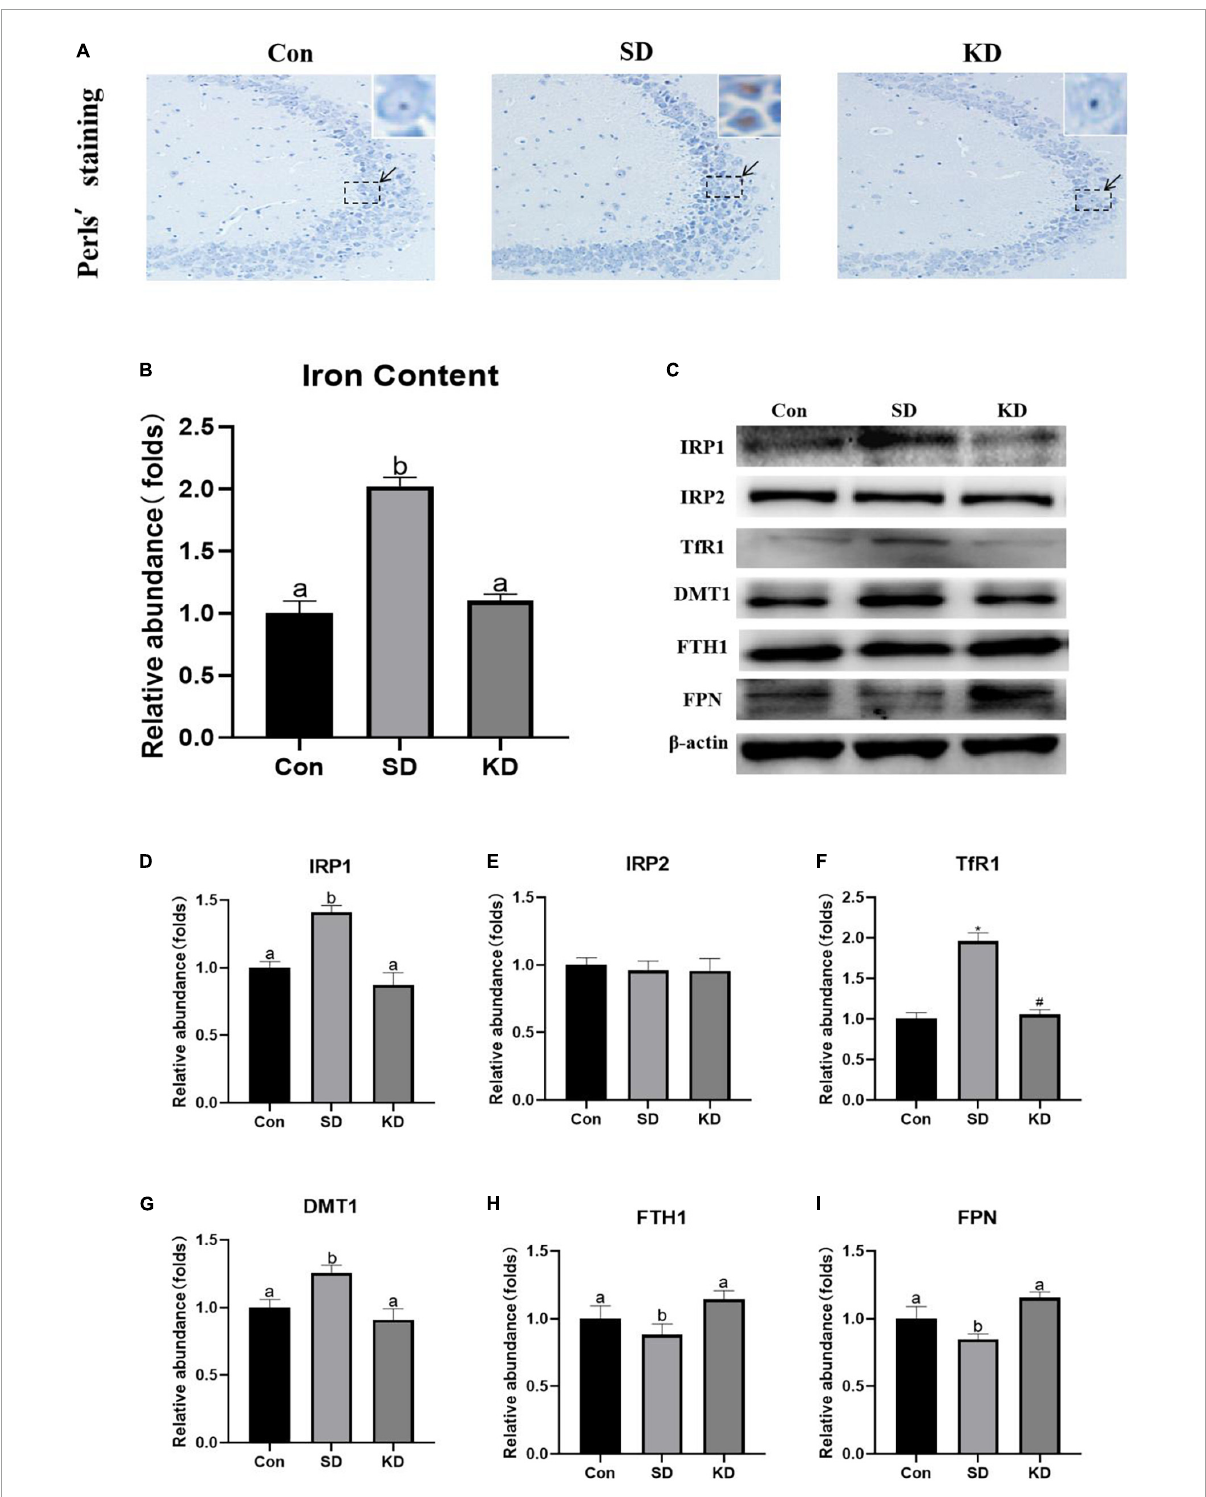
FIGURE5 Effects of ketogenic diet (KD) on iron homeostasis dysregulation in hippocampus induced by chronic sleep deprivation (SD). (A) DAB staining in the hippocampus, scale bars = 50 µ m ( n = 3). (B) Total iron content in the brain and (C) Western-blots and (D–I) densitometry of IRP1, IRP2, TfR1, DMT1, FTH1, and FPN1. Protein levels are normalized to β -actin which served as loading control and reproduced with Sham group. Values are indicated as the mean ± SEM ( n = 7). Different letter indicates significantly different between each group ( p < 0.05); * p < 0.01, compared with Con; # p < 0.01, compared with